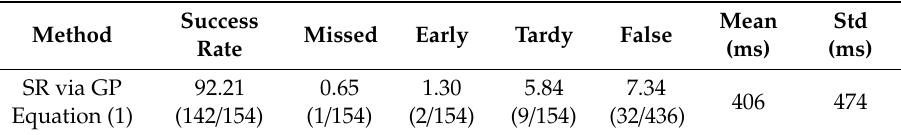
Table 2. The figures of merit obtained with Equation (1) for campaign C31. These statistics have been obtained by applying the final model directly to campaign